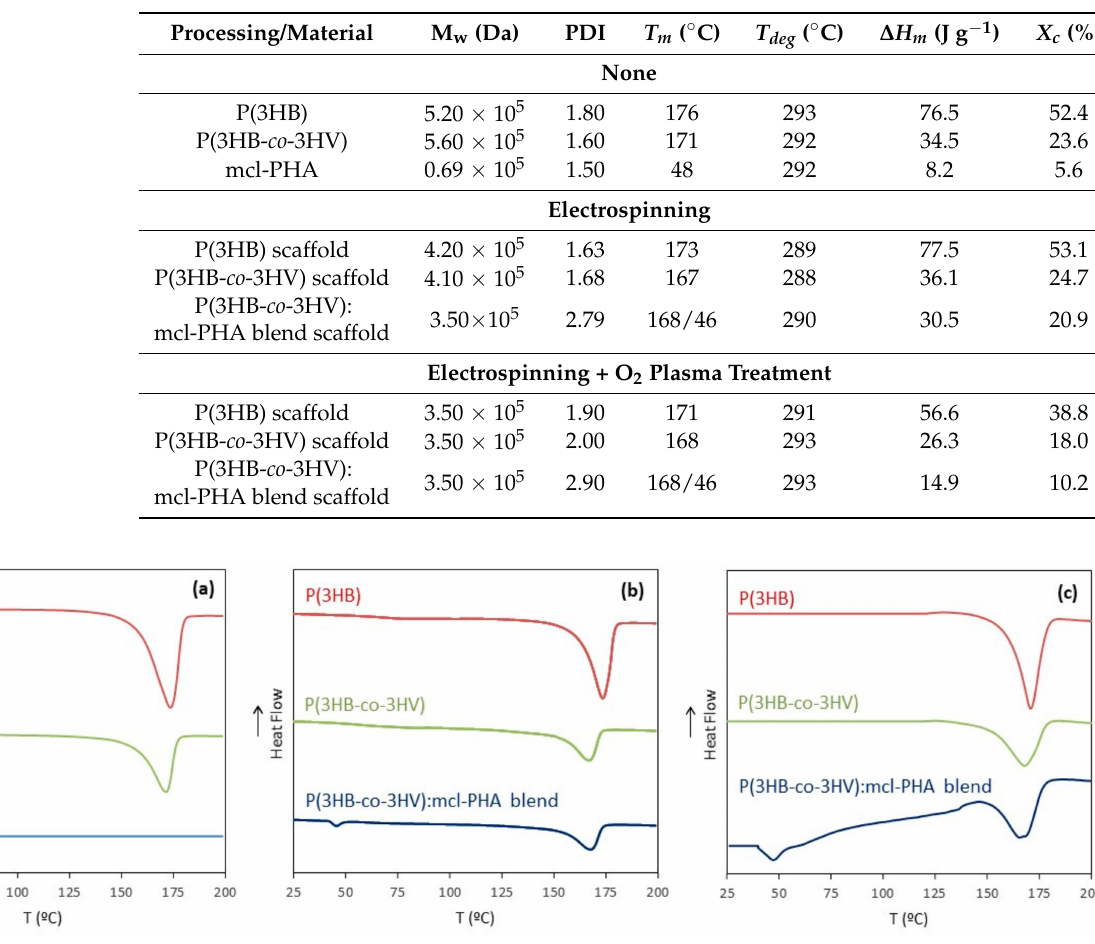
Figure 2. Differential scanning calorimetry (DSC) thermograms for ( a ) the untreated biopolymers, ( b ) the electrospun scaffolds and ( c ) the oxygen plasma treated electrospun scaffolds (red: P(3HB), green: P(3HB-co-3HV), light blue: mcl-PHA in ( a ), dark blue: P(3HB-co-3HV): mcl-PHA blend in ( b , c